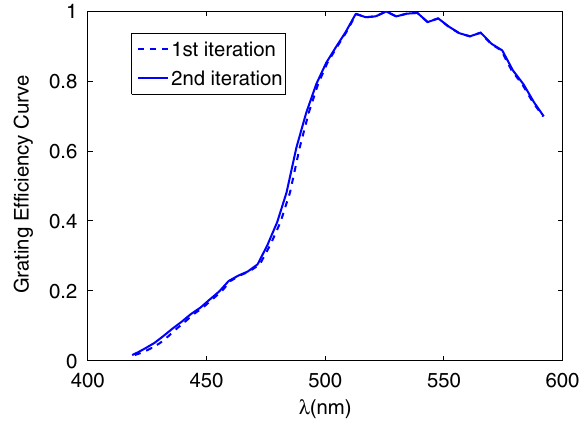
FIG. 12. (Color) The measured grating efficiency curve for the Ocean Optics HR4000 spectrometer. The efficiency curve is calibrated using known spontaneous undulator spectra which are varied to cover the wavelength range of the spectrometer. The efficiency curve converges after a few iterations. The dotted curve is the efficiency curve after the first iteration; and the solid curve is the converged efficiency curve after two